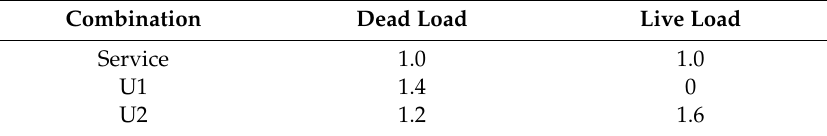
Table 2. Load combinations used in the numerical examples.